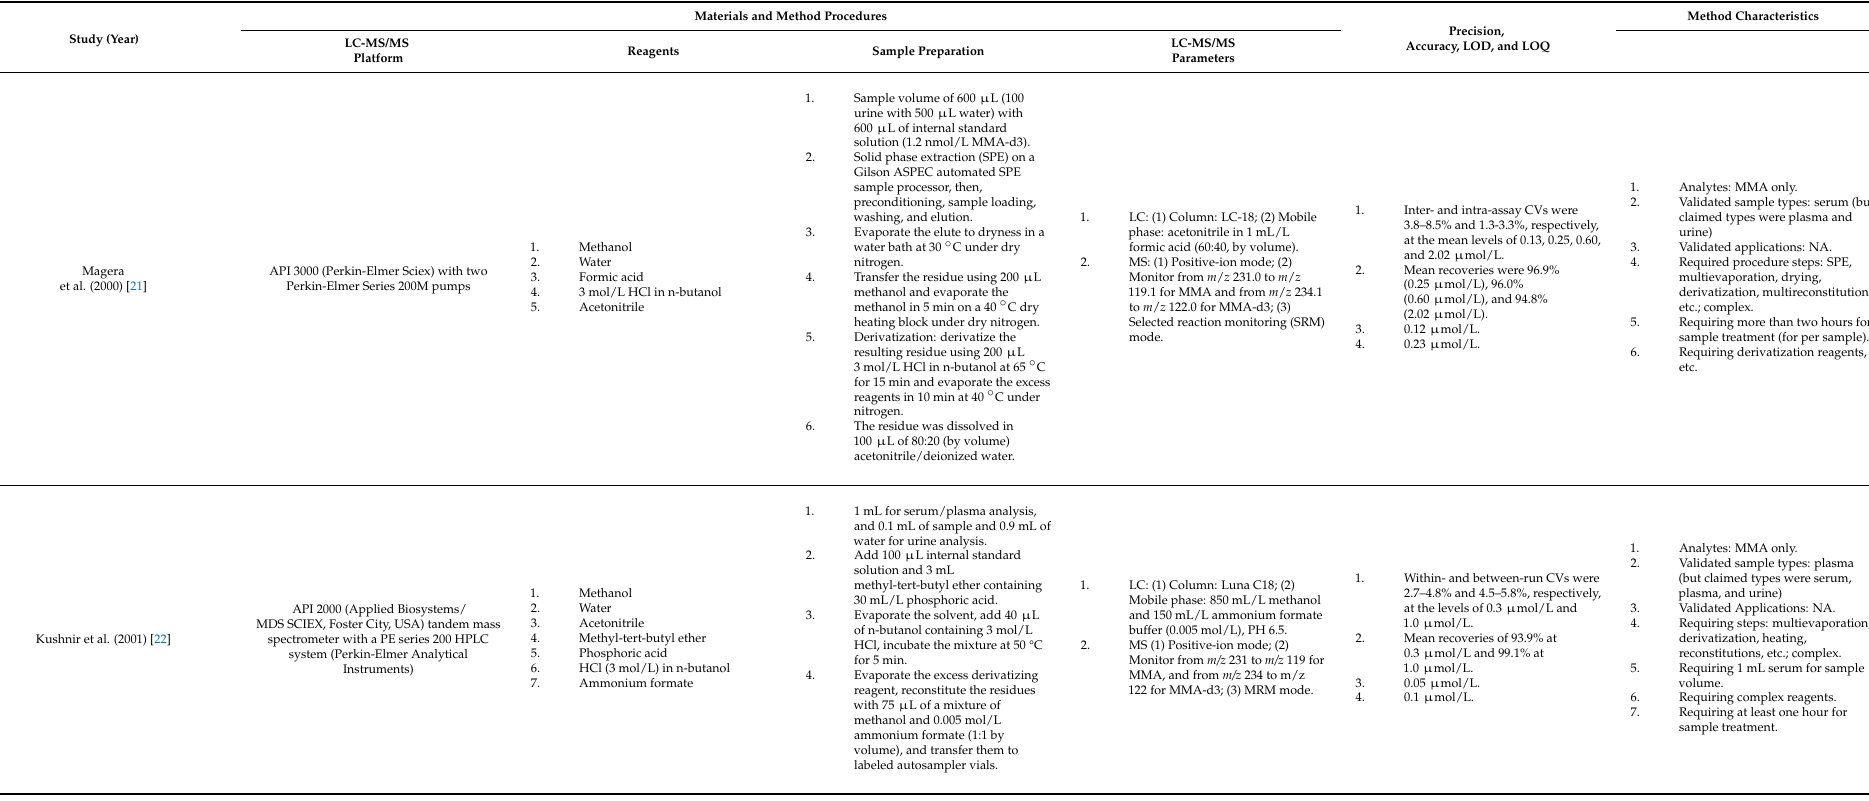
Table 1. A literature review of previous methylmalonic acid quantification based on the liquid chromatography–tandem mass spectrometry method (from 2000 to 2022). Abbreviations of the names of equipment/columns are not listed and abbreviations of reagents are list in the table for reading convenience. Note: LC-MS/MS, liquid chromatography–tandem mass spectrometry; LC, liquid chromatography; MS, mass spectrometry; MMA, methylmalonic acid; LOD, limit of detection; LOQ, limit of quantification; HCl, hydrochloride; SPE, solid phase extraction; SRM, selected reaction monitoring; CVs, coefficient of variations; NA, not available; MRM, multiple reaction monitoring; DBS, dried blood spot; SIM, single-ion monitoring; HPLC, high-performance liquid chromatography; tHcy, total